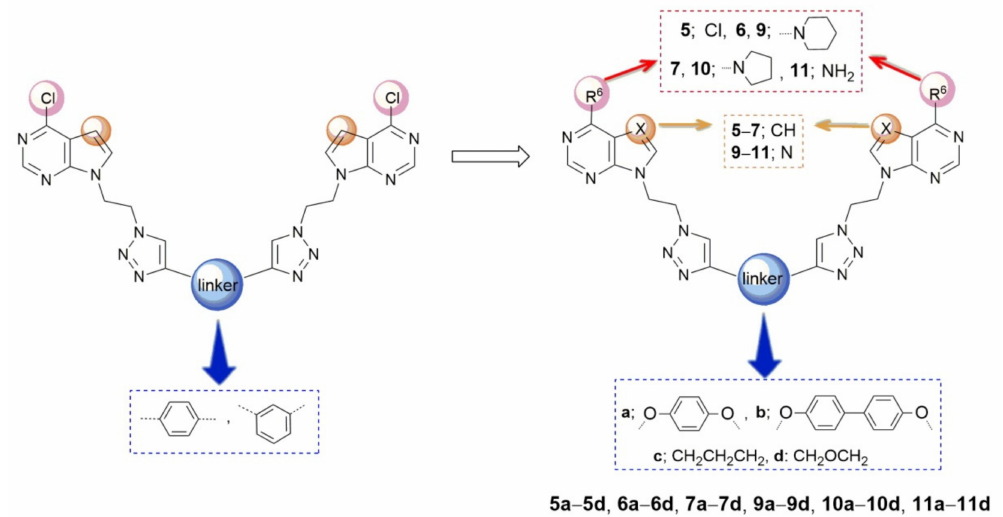
Figure 1. Design of symmetric bis-pyrrolo[2,3-d]pyrimidines ( 5a – 5d , 6a – 6d , 7a – 7d ) and bis-purines ( 9a – 9d , 10a – 10d , 11a – 11d